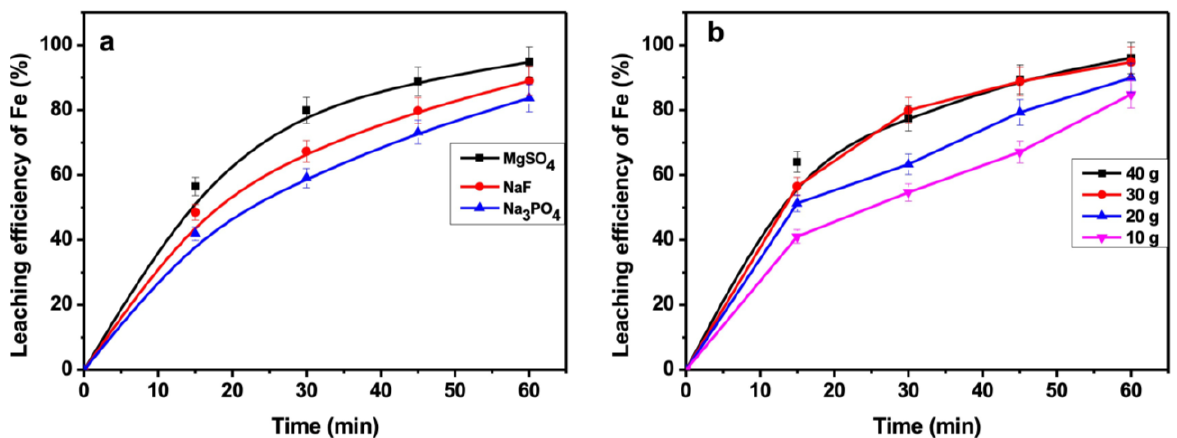
Figure 9. The influence of ( a ) additives and ( b ) magnesium sulphate dosage on leaching efficiency of Fe. Conditions: particle size, +150 µ m; acid concentration, 7.5 M; Fe powder, 6.5 g; solid–liquid ratio, 1:20; agitation speed, 450 rpm; temperature, 90 ◦ C; agitation time, 60